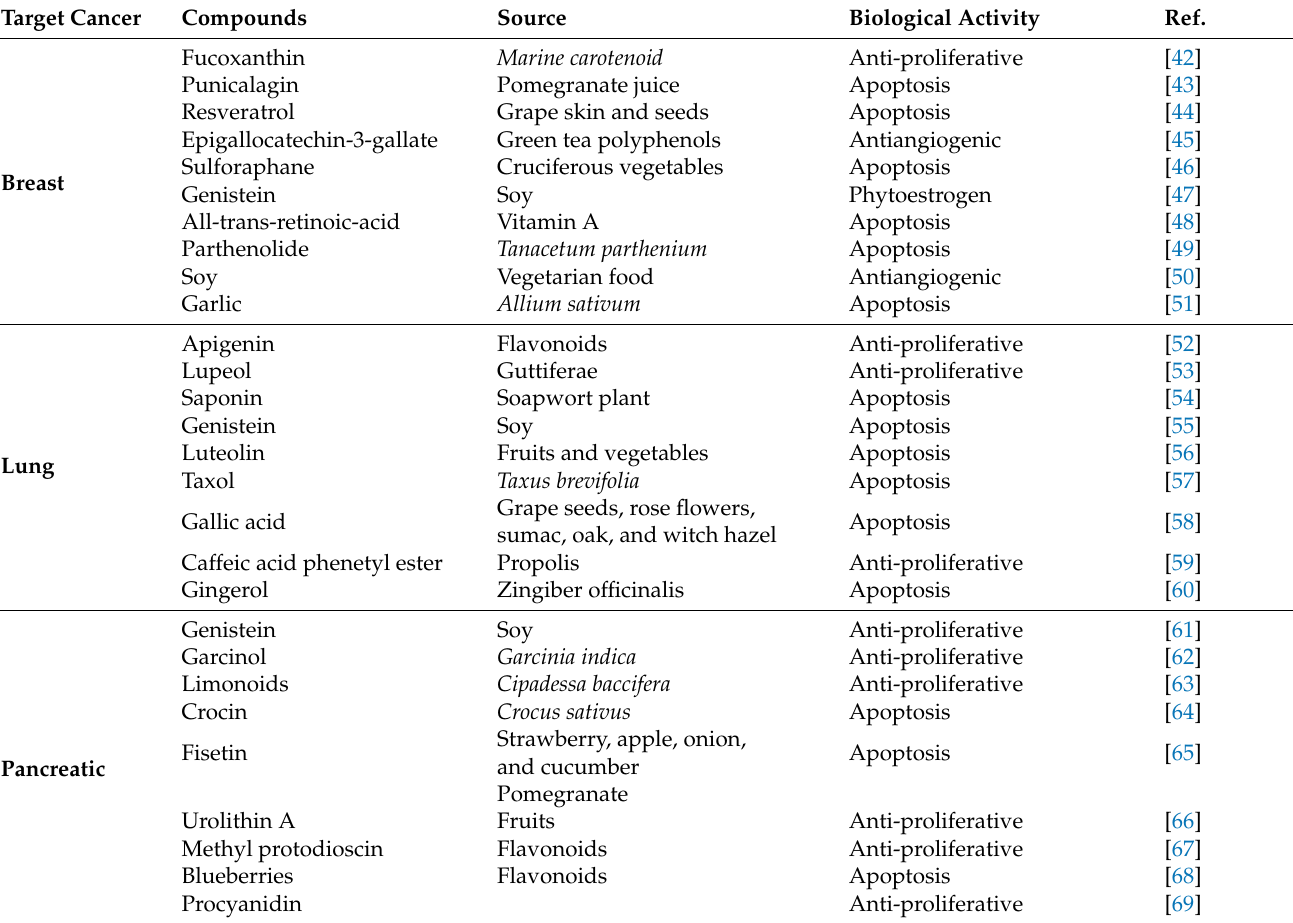
Table 1. Natural compounds with anticancer